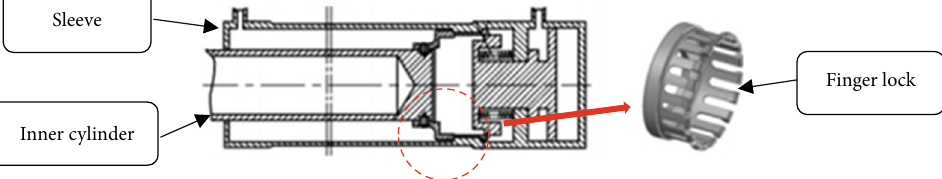
Figure 2: Assembly drawing of the fi nger lock.